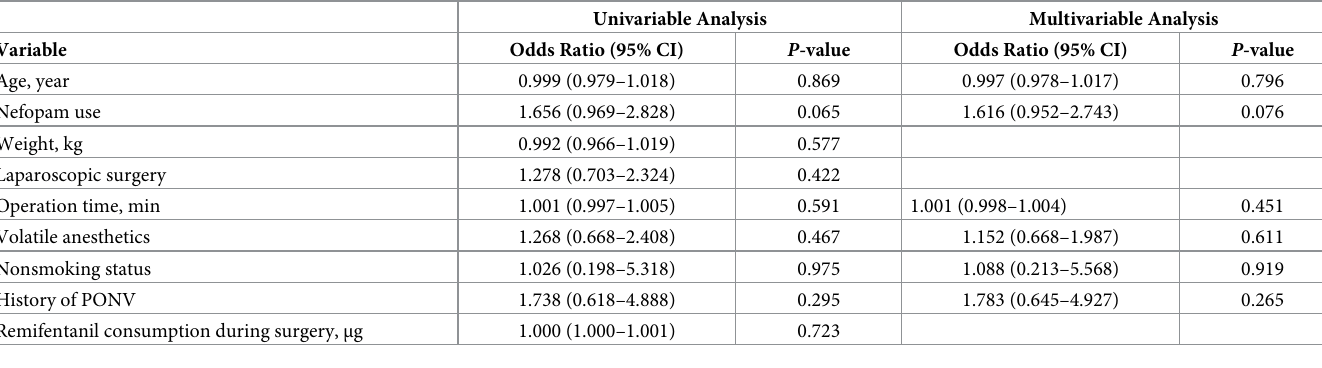
Table 5. Multivariable analysis of patient characteristics associated with postoperative nausea and